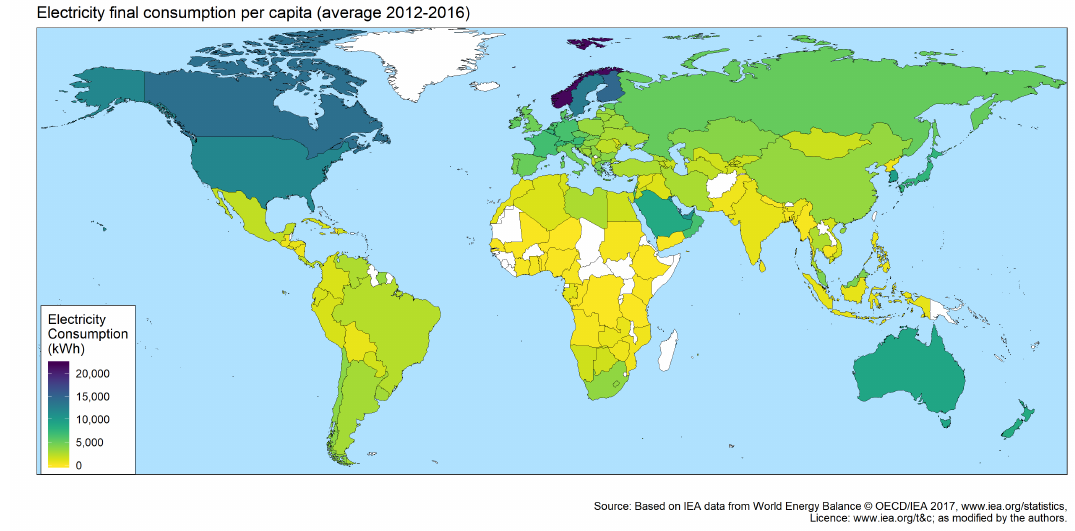
Figure 1. Average annual per-capita total final consumption of electricity (TFC),